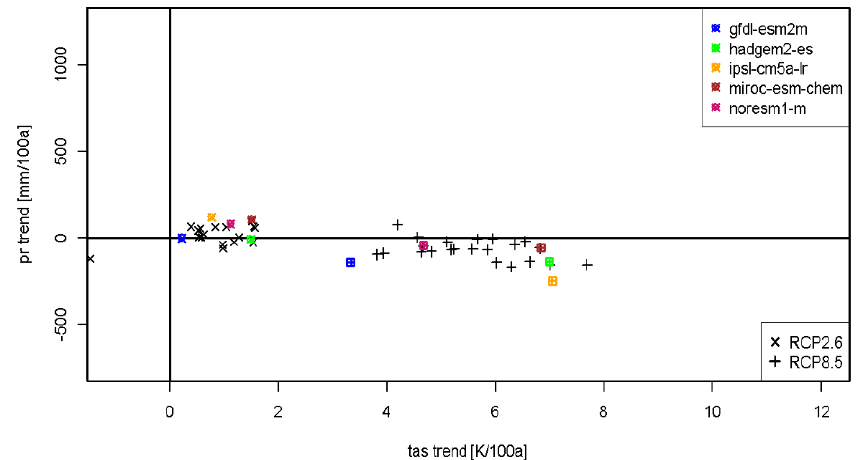
Figure 6. Trends in precipitation and temperature for the Danube region as simulated by 23 GCMs until the end of this century. The x-axis shows the global warming trend of a respective GCM simulation until the end of the 21st century compared to that preindustrially (1850–1900) in Kelvin/100 years. The y-axis shows the corresponding precipitation trend. In color: the five selected Inter-Sectoral Impact Model Intercomparison Project (ISI-MIP) [33] scenario runs for representative concentration pathways RCP2.6 and